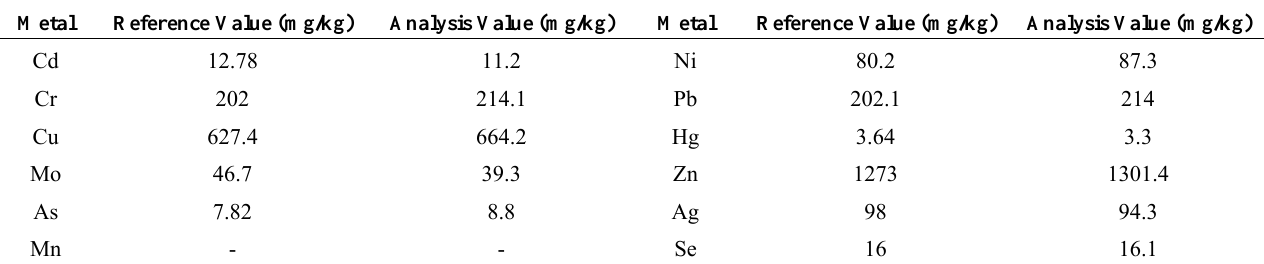
Table 1. Analysis results of standard reference materials (NIST 2781) by